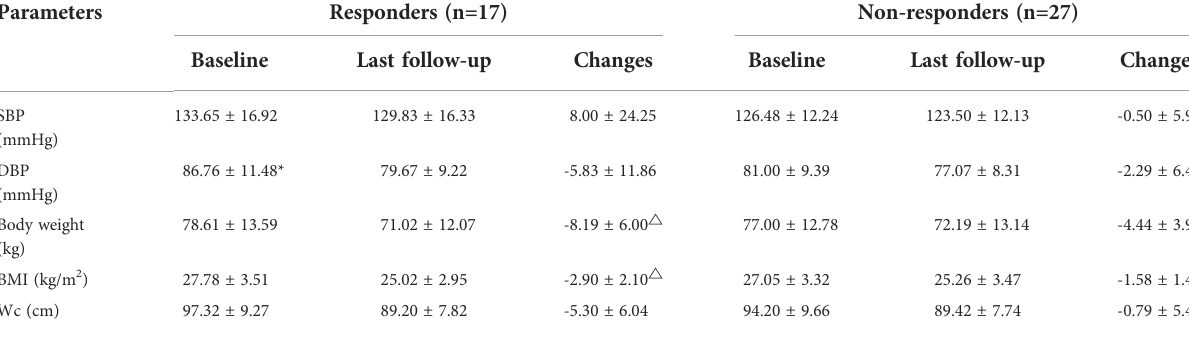
TABLE 6 Anthropometric parameters at baseline and the last follow-up in responders and non-responders. Parameters